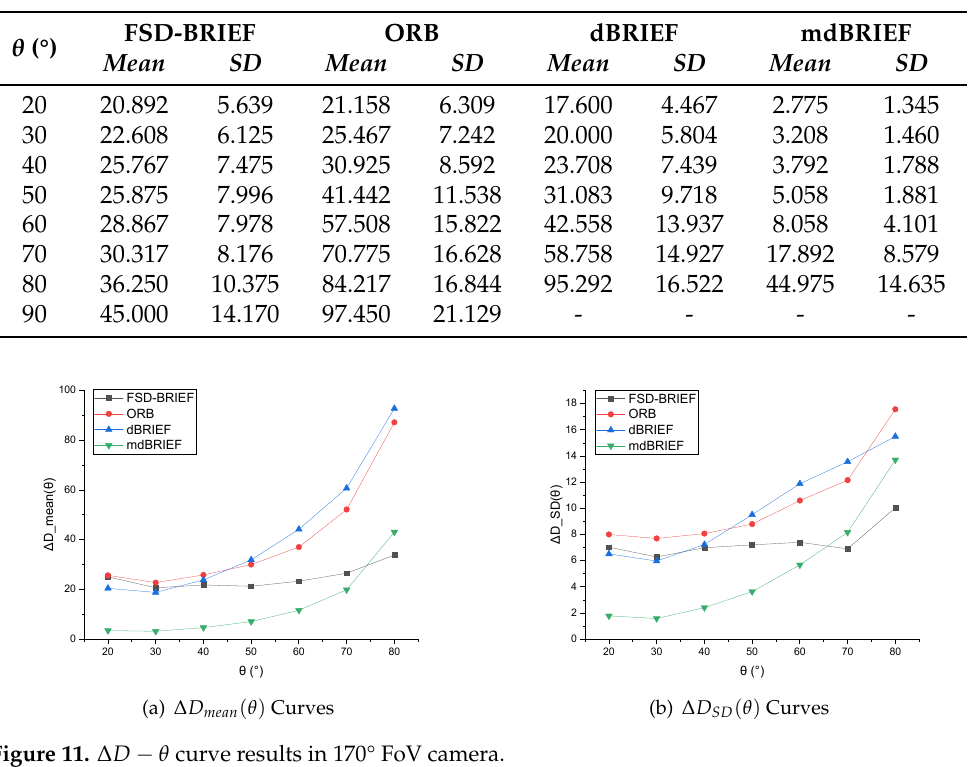
Table 5. The numerical results of Hamming distance error in 210° FoV camera.